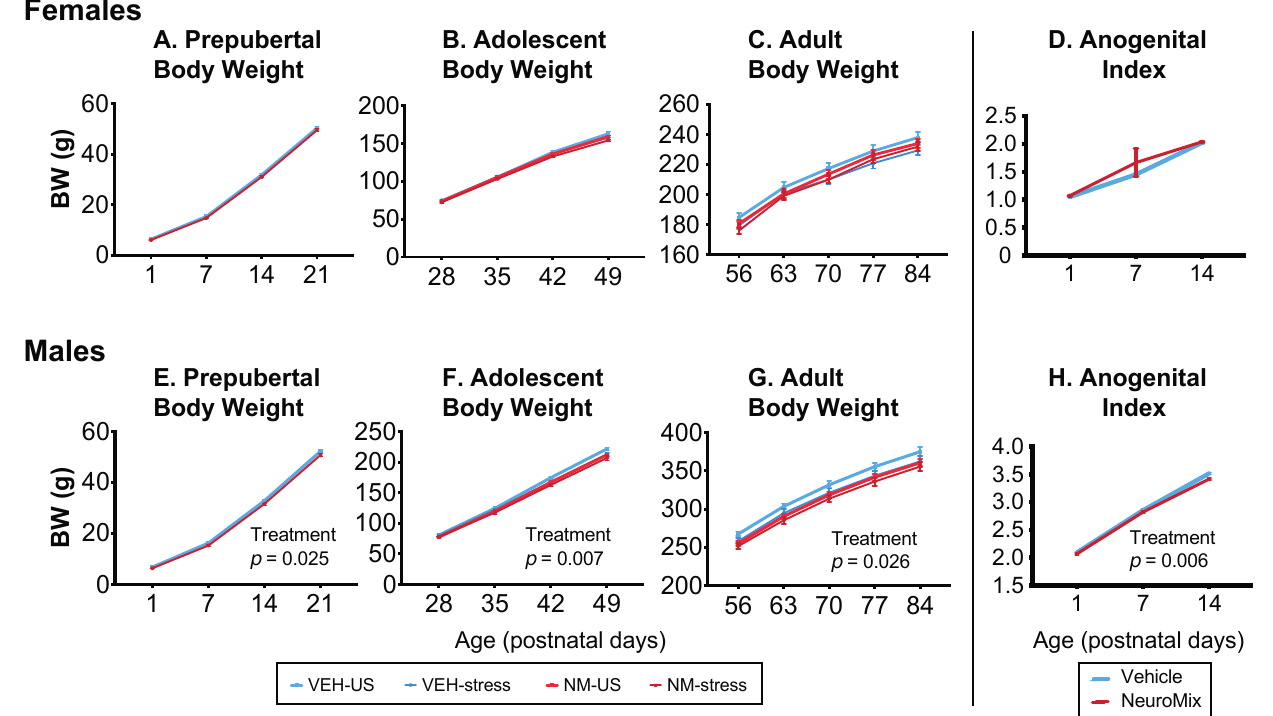
Figure 1. Effects of prenatal NeuroMix and/or stress in adolescence on body weight in females ( A – C ) and males ( E – G ) across prepubertal, adolescent, and adult life stages. In females, there were no effects of treatment or stress. In males, repeated measures ANOVA found that body weight was significantly affected by treatment through each of the three life stages. Specifically, vehicle–unstressed rats had higher body weights than the other groups; p -values for the main effects of treatment are indicated in panels ( E – G ). Anogenital index (AGI) in prepubertal rats was unaffected in females ( D ) and was sig- nificantly decreased by NeuroMix in males, with the p -value for the significant main treatment effect shown ( H ). Prepubertal females: n = 46 vehicle and 52 NeuroMix; prepubertal males: n = 49 Vehicle, n = 52 NeuroMix. For vehicle–unstressed, vehicle–stressed, NeuroMix–unstressed, and NeuroMix– stressed adolescent and adult females, n = 27, 19, 30 and 22; for males, n = 28, 21, 30, and 22. Males: Prior to puberty, body weight was decreased by NeuroMix ( p = 0.025; Figure 1E). In adolescence, during which restraint stress was given to a subset of rats from P35 to P44, NeuroMix treatment ( p = 0.007) decreased body weight, and there was a trend for stress to decrease body weight ( p = 0.055; Figure 1F). Similar results were found in adulthood (treatment: p = 0.026; stress: p = 0.097; Figure 1G). There were no interactions of treatment and